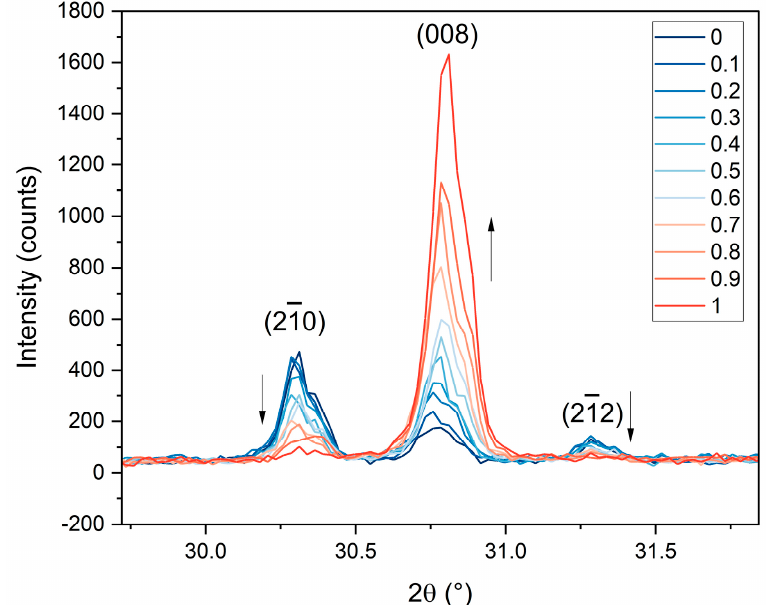
Figure 6. The intensity of XRD (008) reflection increases with the molar ratio between goethite and hematite.